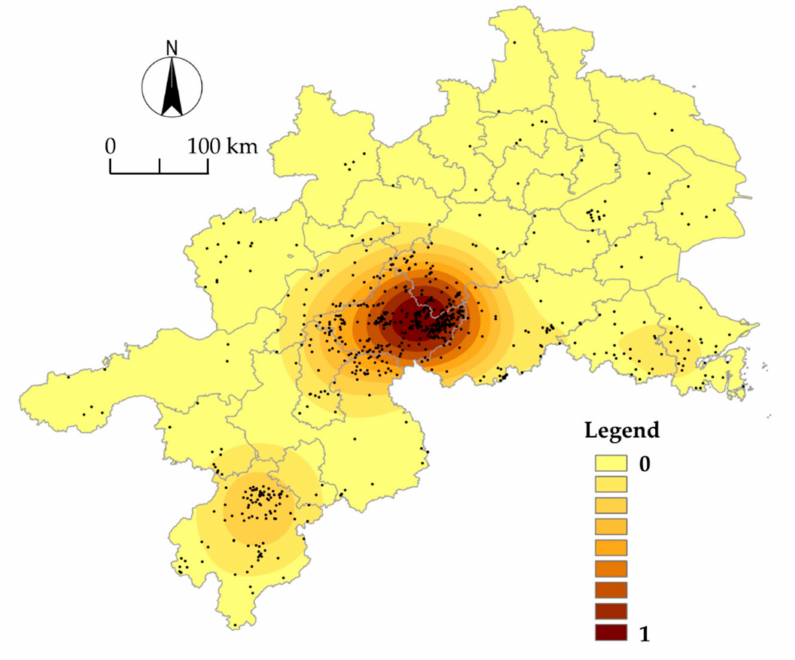
Figure 6. Aggregation patterns in Jiangnan region: edited by